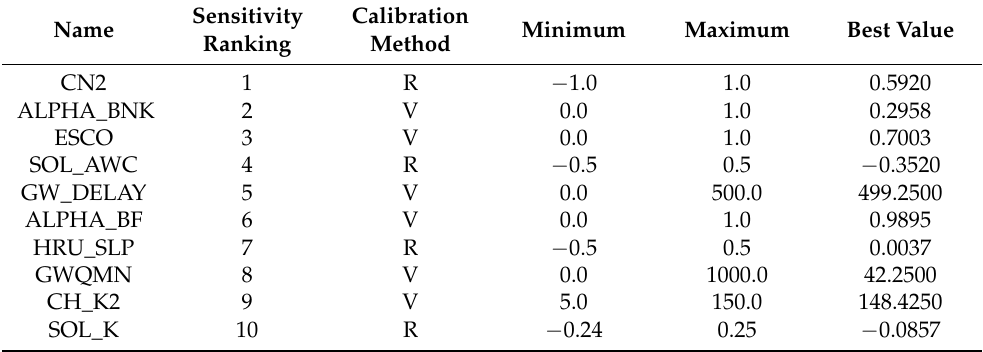
Table 2. Sensitivity analysis and value range of SWAT model parameters in Tahe River Basin.